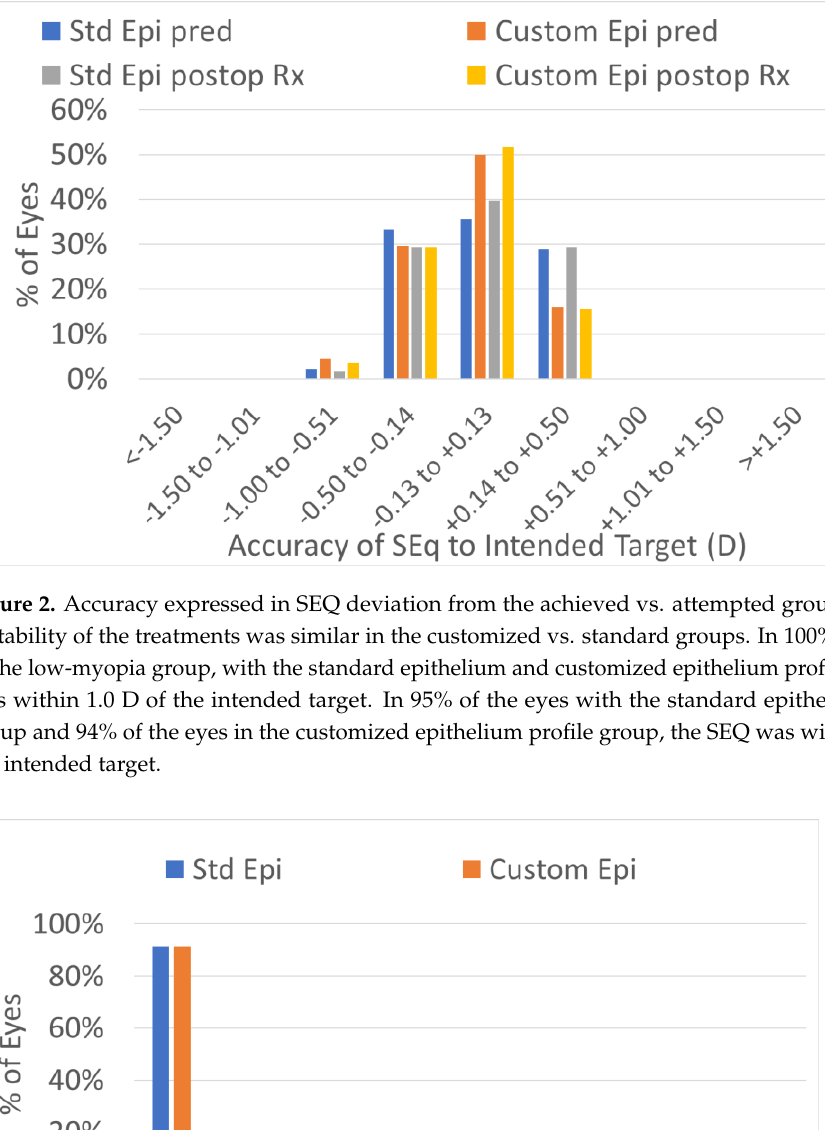
Figure 1. Predictability of the achieved vs. attempted spherical equivalent (SEQ) for both low- myopia groups. The customized epithelium group exhibited a small undercorrection. The regression analysis and R coefficient of determination, in both groups, were near to 1. The predictability of the treatments was similar in the two groups. The scattergram of the achieved vs. attempted correction was very similar for both groups.